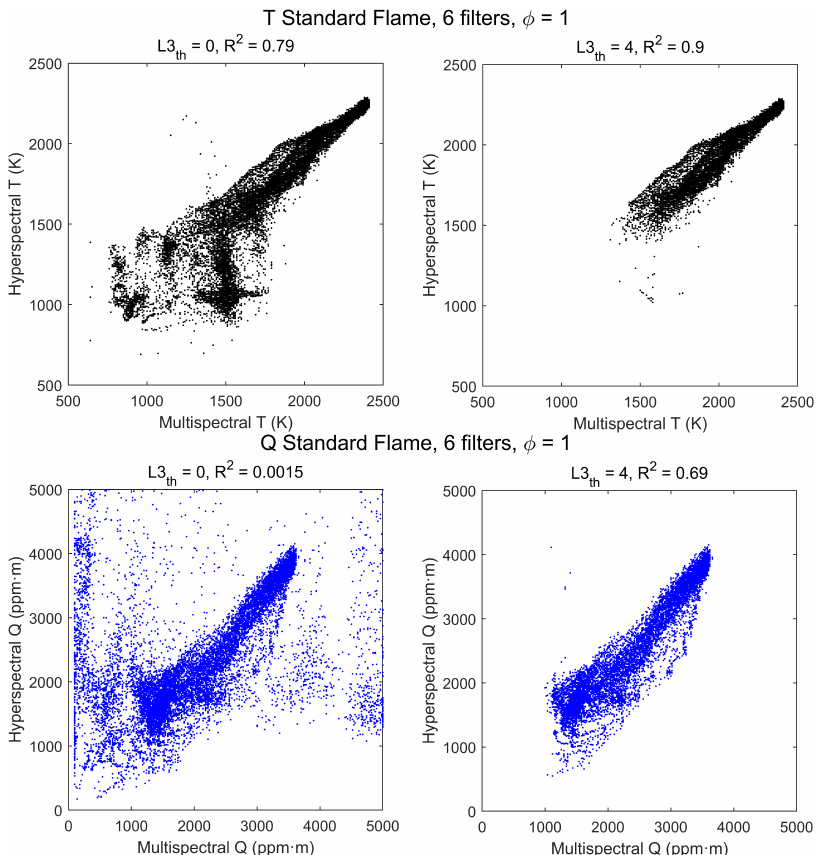
Figure 7. Scatterplots of hyperspectral vs. multispectral retrieved values of T ( top row ) and Q ( bottom row ) for the stoichiometric ( φ = 1) standard flame. Each point corresponds to a pixel, with no radiance threshold ( left column ) and with threshold L3 th = 4 W/m 2 · sr · cm − 1 ( right column ). The agreement between temperatures measured by the hyperspectral method, T H by the multispectral method, T M , can be quantified by the average of relative errors (ARE) i − T M | / T H (cid:105) (and, in an analogous way, for Q M of the T M values, defined as ARE ≡ (cid:104)| T H i i i i